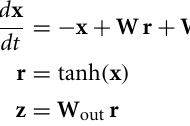
FIGURE 1 | Spatiotemporal Pattern Reproduction task data. (A) Top panel: Distribution of response times for each key press (dotted lines), with Gaussian fits (solid lines), for a complex pattern from one subject; Bottom panel: the target pattern. Colors cyan, blue, red, and green, correspond to fingers 2 (index) through 5 (pinky). A systematic anticipation is noticeable at the longer responses in this subject. Although some subjects tended to produce early responses and others late, across subjects there was a tendency to anticipate the target time, particularly at the last responses in the pattern. On the last day of training the difference between the response time and target time at the first element in the pattern was (mean ± SD) 25 ± 75ms ( p = 0.26), whereas for the last element it was